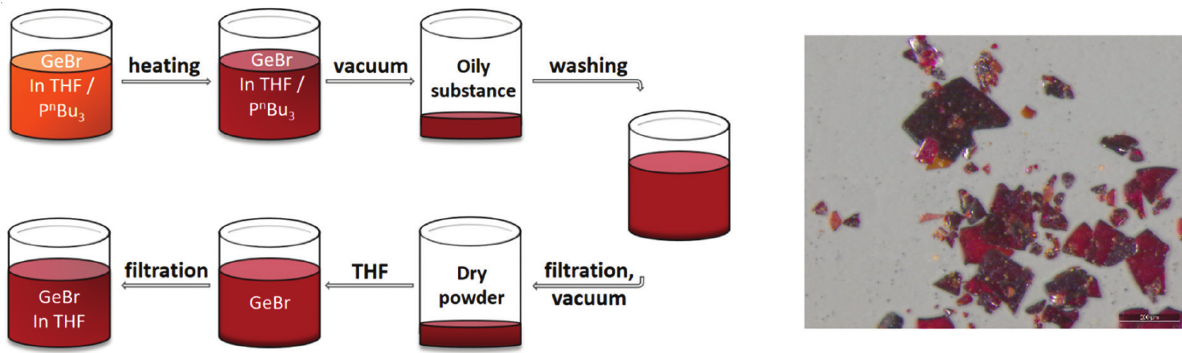
Figure 2: Schematic of the synthesis of colloidal GeNP including an image of dry